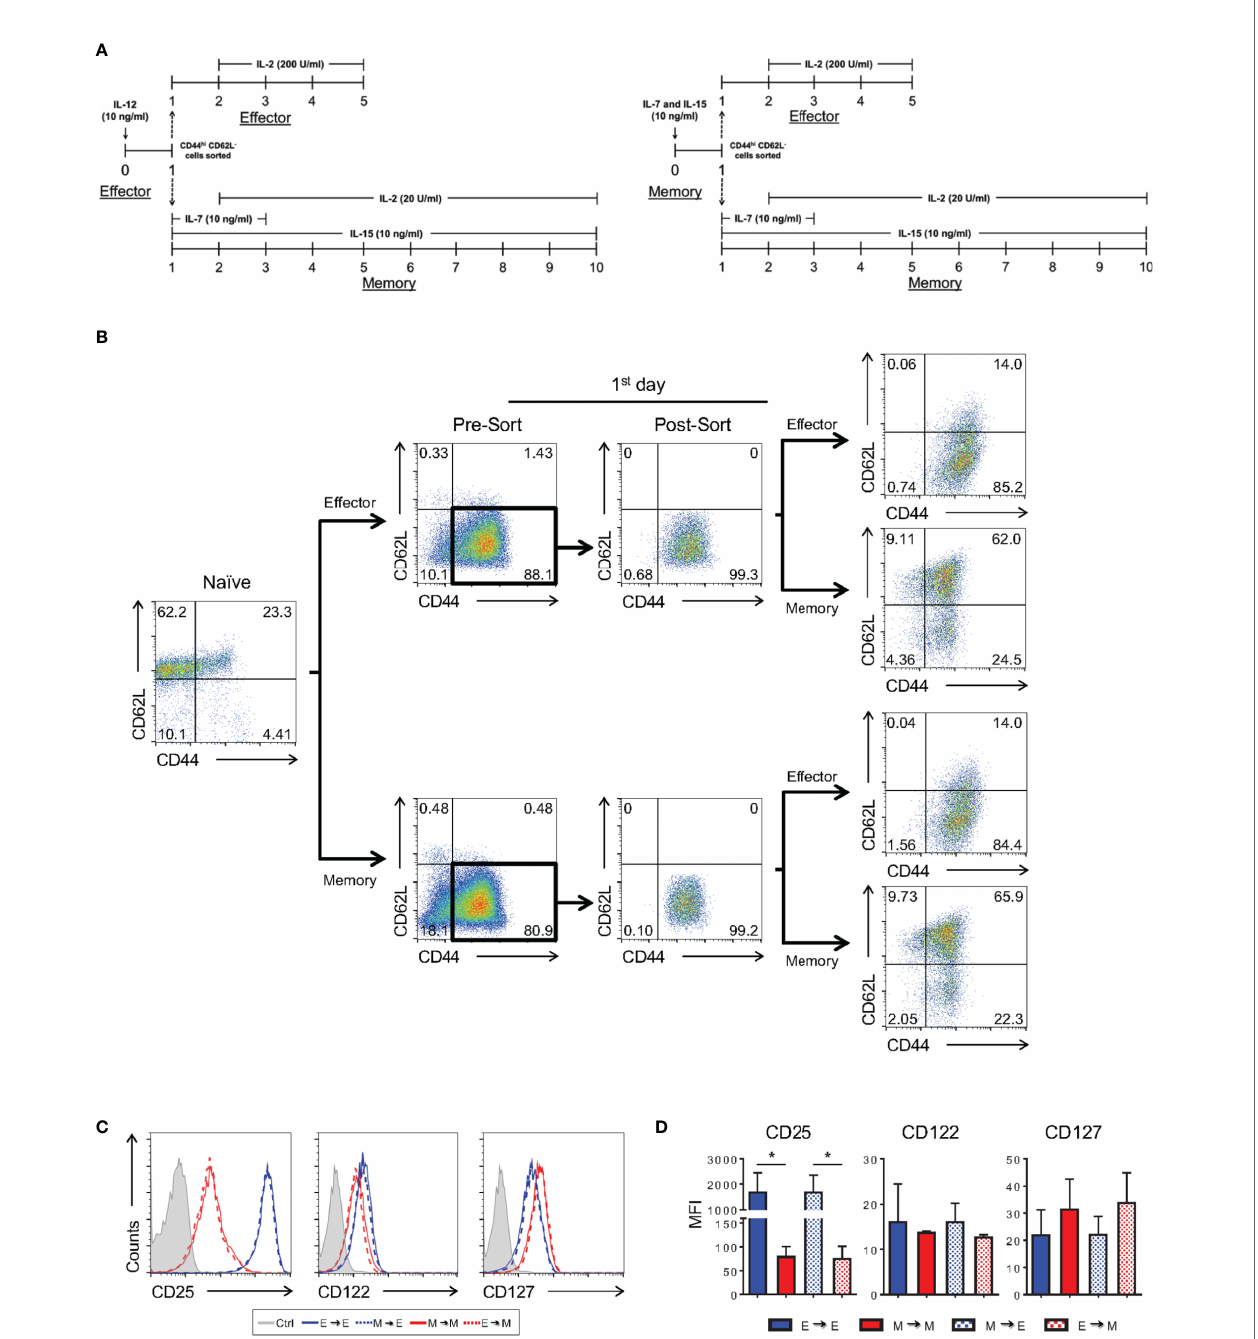
FIGURE 10 | Plasticity of In Vitro CD8 T Cell Differentiation in the Early Stages after Activation. (A) Schematic representation of the differentiation regimen upon activation and after cell sorting. Timeline on the left depicts cultures that started as effector cells and on the right, that started as memory cells. (B) Flow cytometric analysis according to cell-labeling with anti-CD44 and anti-CD62L fl uorescently labeled antibodies along the experiment. Brie fl y, 24h after activation, CD8 T lymphocytes under in vitro effector or memory conditions were sorted based on CD44 hi CD62L - staining. The sorted cells were maintained in the same differentiation condition (control) or subjected to a different protocol (memory or effector), completing the remaining 24 h of the respective activation regiment. The effector and memory cells were analyzed at day 5 and 10 of culture, respectively. (C) In vitro -differentiated effector and memory CD8 T lymphocytes were labeled with anti-CD25, anti-CD122 and anti-CD127 fl uorescently labeled monoclonal antibodies on days 5 and 10 of culture, respectively. (D) MFI of anti-CD25, anti-CD122 and anti- CD127 labeling. All data are shown as the mean ± SD. The (*) indicates p < 0.05 compared with the effector. All results are representative of three independent experiments. Ctrl: unlabeled (gray); effector to effector (blue); memory to memory (red); memory to effector (blue and white) and effector to memory (red and